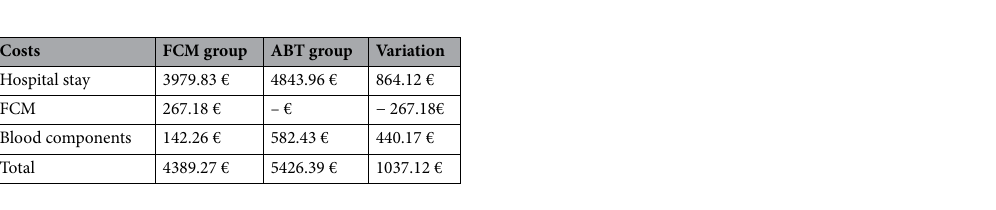
Table 9. Direct and Indirect costs